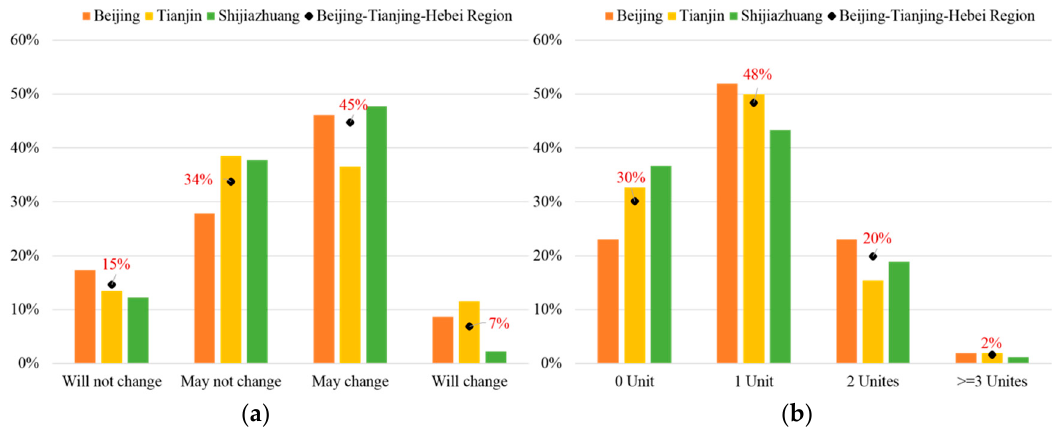
Figure 10. Survey results on respondents’ car ownership and whether they will change their willingness to buy new cars or to replace old cars in the future. Multiple panels: ( a ) Ownership of private cars of respondent; ( b ) Willingness to buy a new car or replace old cars.